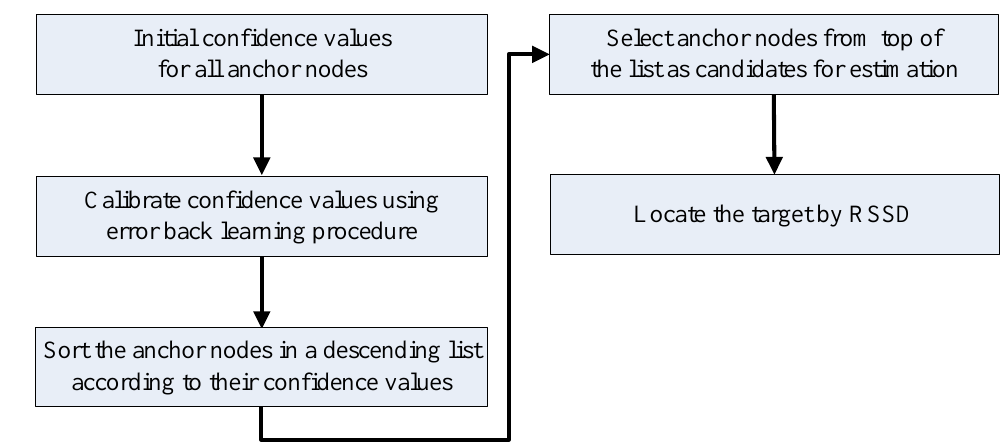
Figure 3. Procedure of localization by RSSD without energy control.